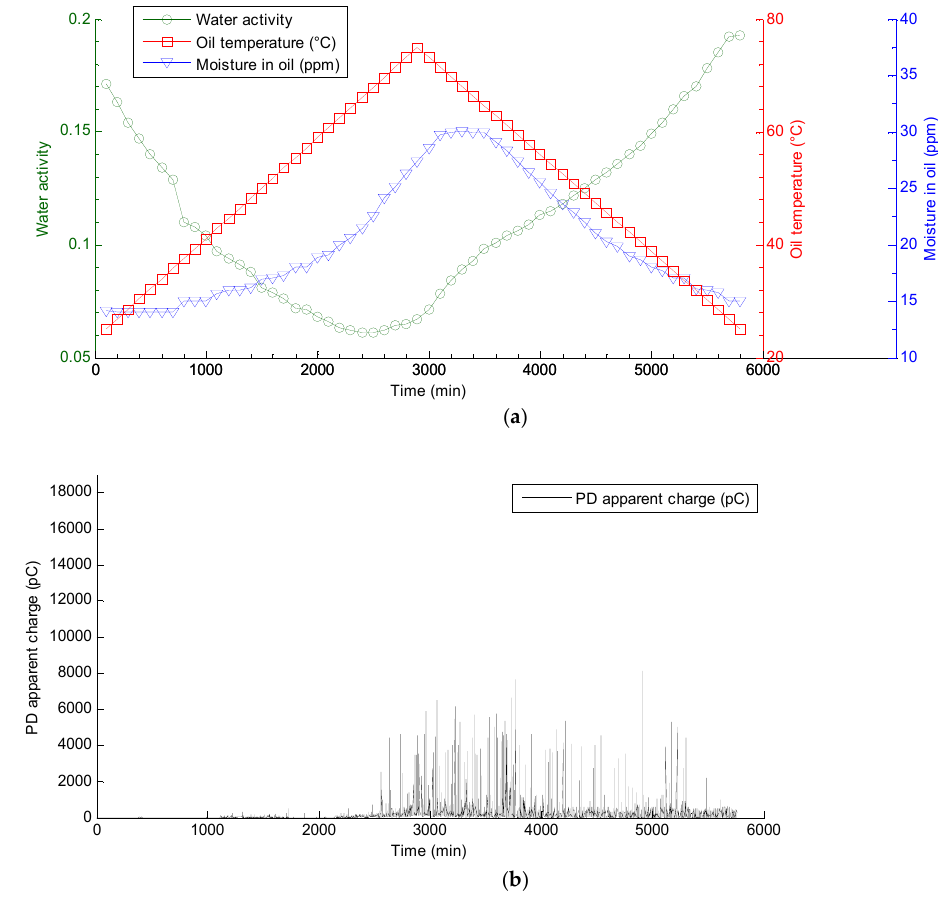
Figure 9. Typical experimental results obtained for an insulation sample with a moisture content of 2.5%: ( a ) water activity, temperature and moisture content of oil; and ( b ) PD apparent charge.